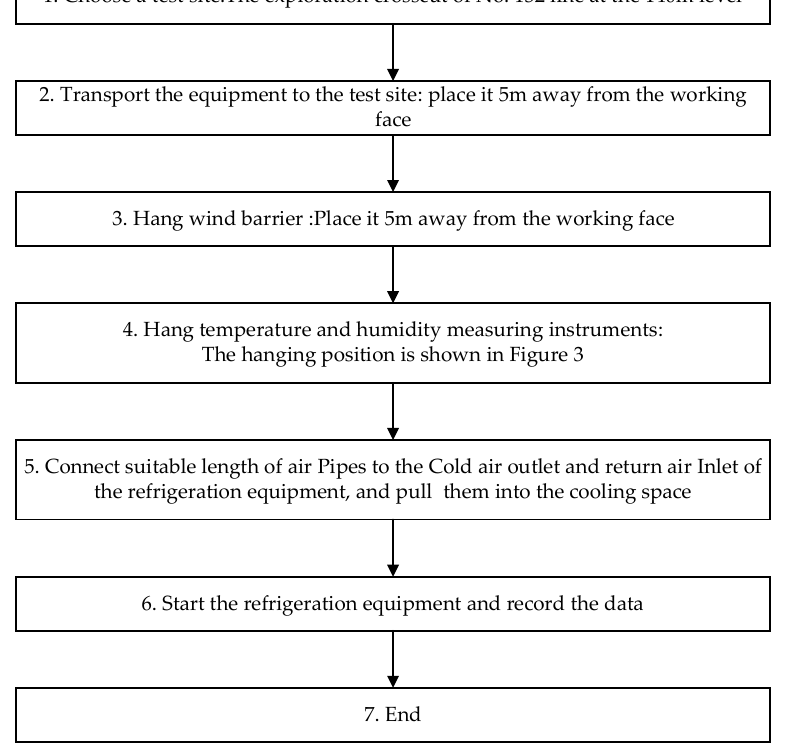
Figure 5. Field test process.